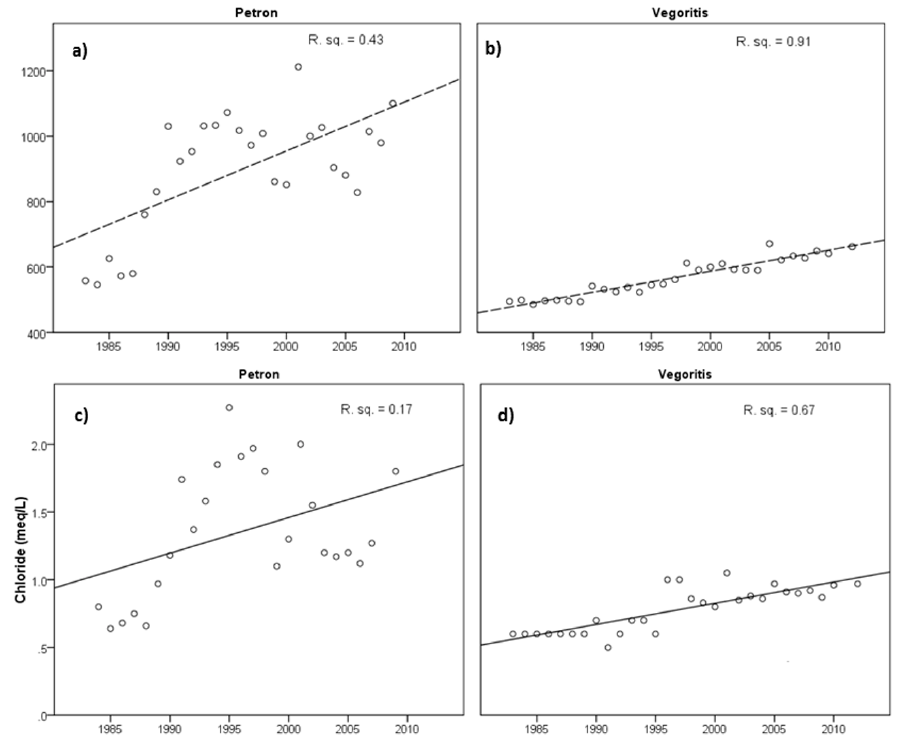
Figure 7. Conductivity ( a , b ) and chloride concentration ( c , d ) rising trends for the two studied lakes over a period of 18 consecutive years (1983–2001).